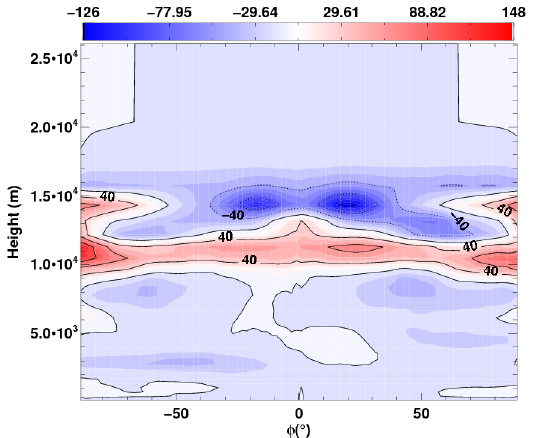
Figure 23. Figure, for the tidally locked Earth test (Merlis and Schneider, 2010; Heng et al., 2011b), showing the differences EG– Fig. 23. Figure, for the Tidally Locked Earth test (Merlis and ND of the zonally and temporally averaged EKE (see Table 2 for Schneider, 2010; Heng et al., 2011b), showing the differences explanation of model EG − ND of the zonally and temporally averaged EKE (see Table 2 for explanation of model types).